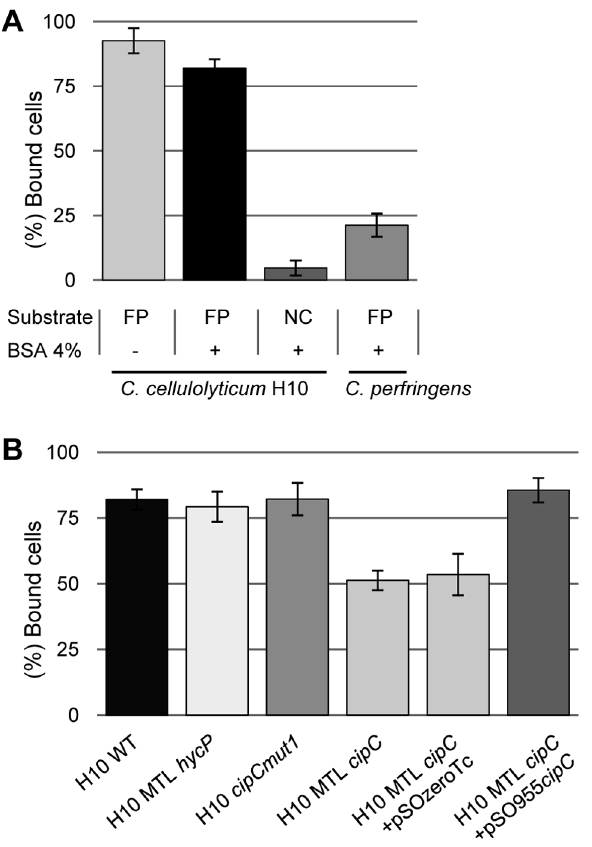
Figure 5. Cell adherence to cellulosic substrates. Cells cultured on cellobiose were incubated one hour in anaerobic conditions with a strip of insoluble substrate. Binding percentage is calculated from the level of unbound cells measured in the supernatant by spectropho- tometry (optical density at 450 nm) compared to the optical density value of an assay where no insoluble substrate was added. (A) Clostridium cellulolyticum is incubated on filter paper (FP) or on nitrocellulose (NC) strips with or without BSA saturation and compared to the binding level of Clostridium perfringens to BSA saturated filter paper. (B) Cellulose binding capacity of C. cellulolyticum wild-type strain, MTL hycP , MTL cipC , MTL cipC (pSOS955 cipC ), MTL cipC (pSOSzero-Tc), and cipCmut1 mutant strains. Experiments were performed in triplicates, on at least three independent experiments and two isolated clones for MTL hycP , MTL cipC , MTL cipC (pSOS955 cipC ) and MTL cipC